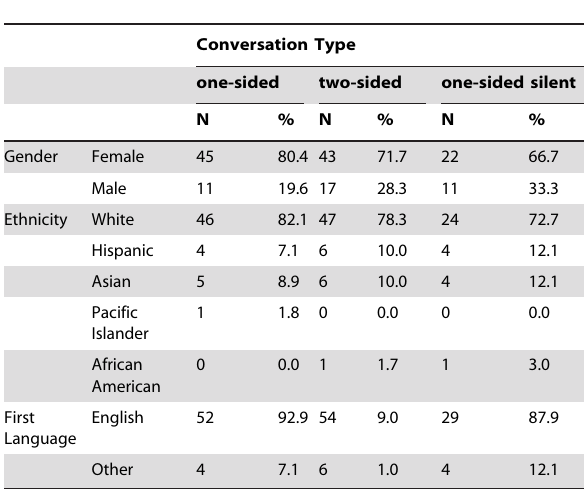
(Table 1) or age (Table 2). A second Chi-square test comparing participants in the combined one-sided group versus the two-sided